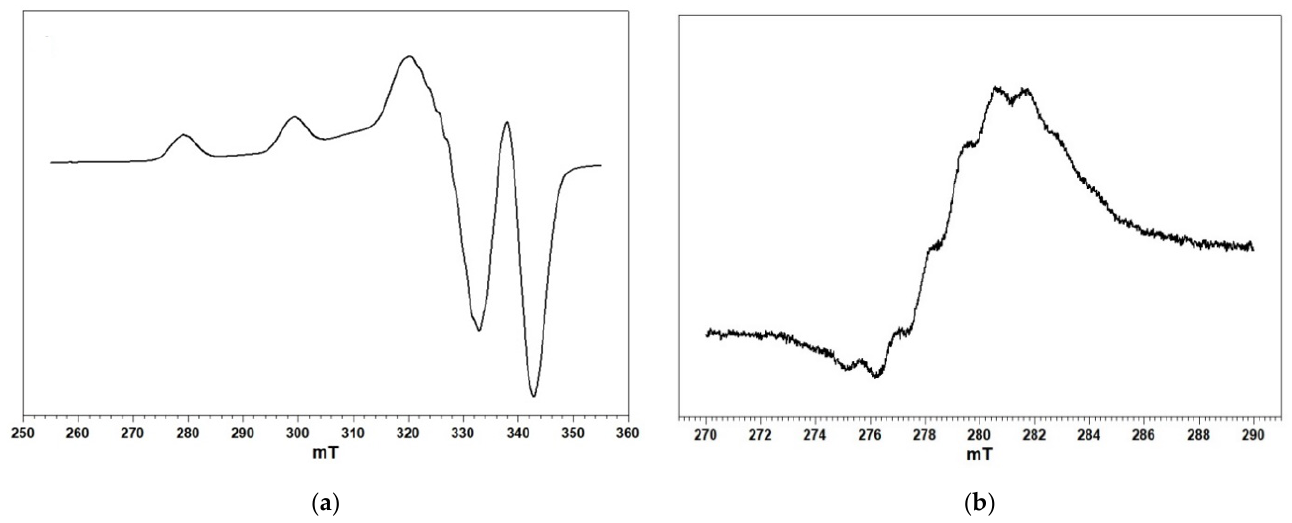
Figure 8. ( a ) LT EPR spectra of Cu-GFH in frozen aqueous solution at pH 7–8 and ( b ) LT EPR 2nd derivative spectrum of the lowest magnetic field feature of Cu-GFH in frozen aqueous solution at pH 7–8.